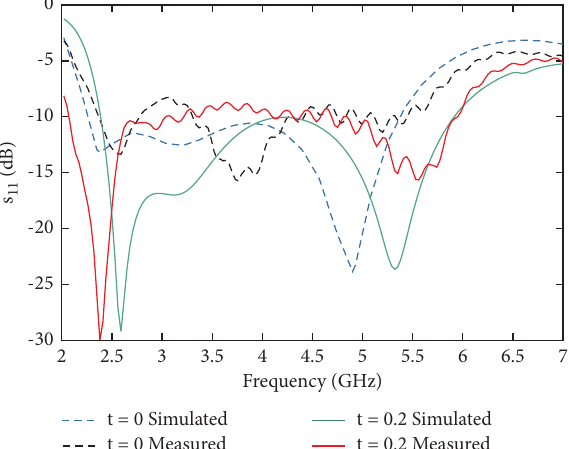
Figure 9: Simulated and measured antenna S